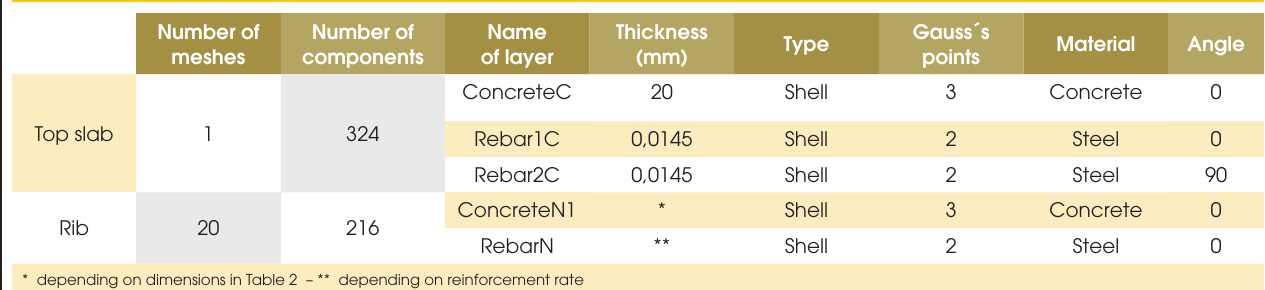
Table 3 – Parameters for layered shell elements